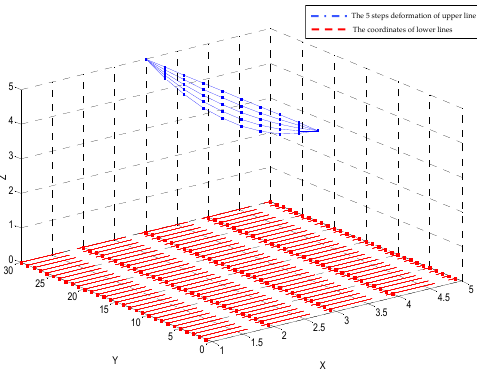
Figure 5. Using five steps to split the deformation of a tactile sensor.